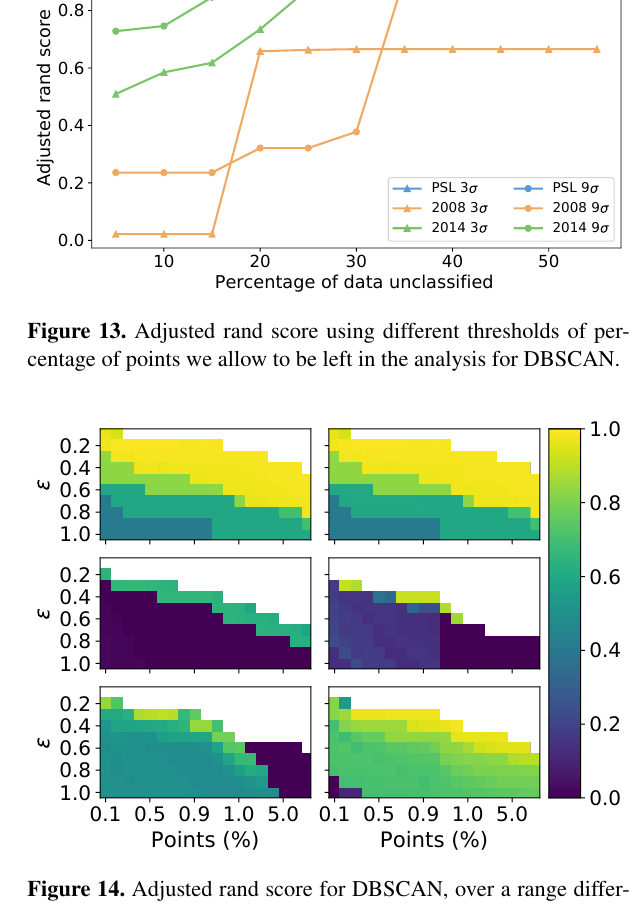
Table 9. Matching matrix for the worst case scenario when using DBSCAN with 3 σ , (cid:15) = 0 . 3 and a minimum number of points of 0.4% on the 2008 data.